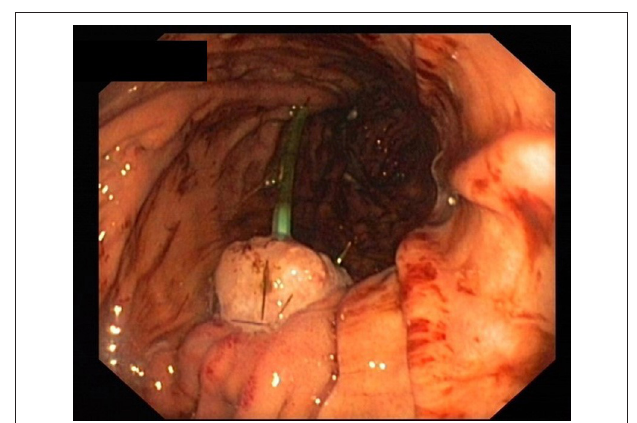
FIGURE 1 | Implanted pancreatic stump with duct drainage.